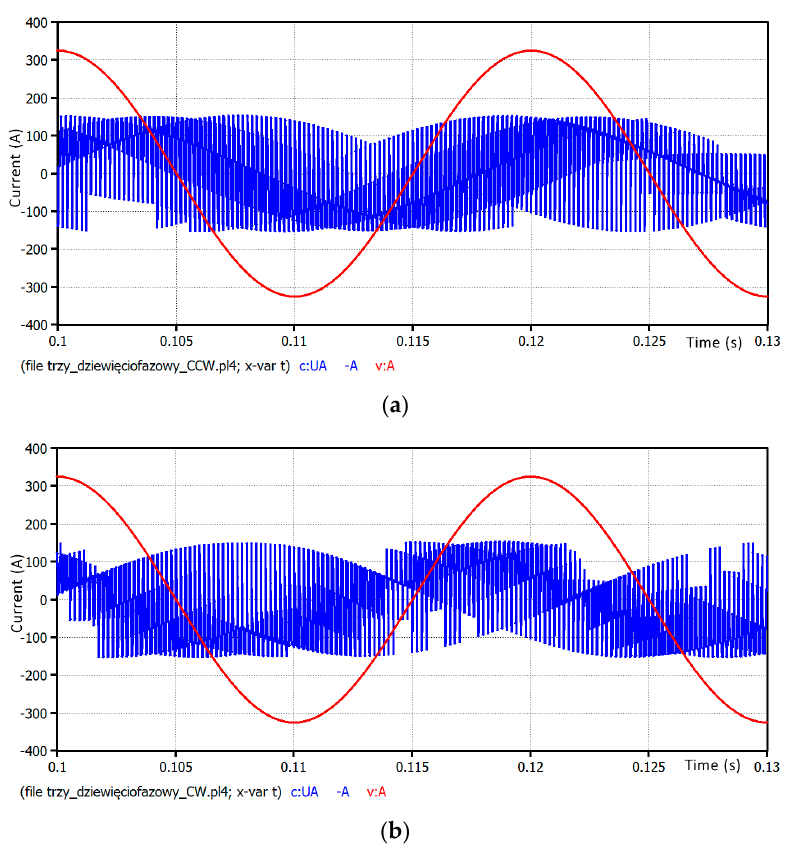
Figure 6. Input voltage (red) and current (blue) waveforms of phase a for ( a ) CCW method; ( b ) CW method.